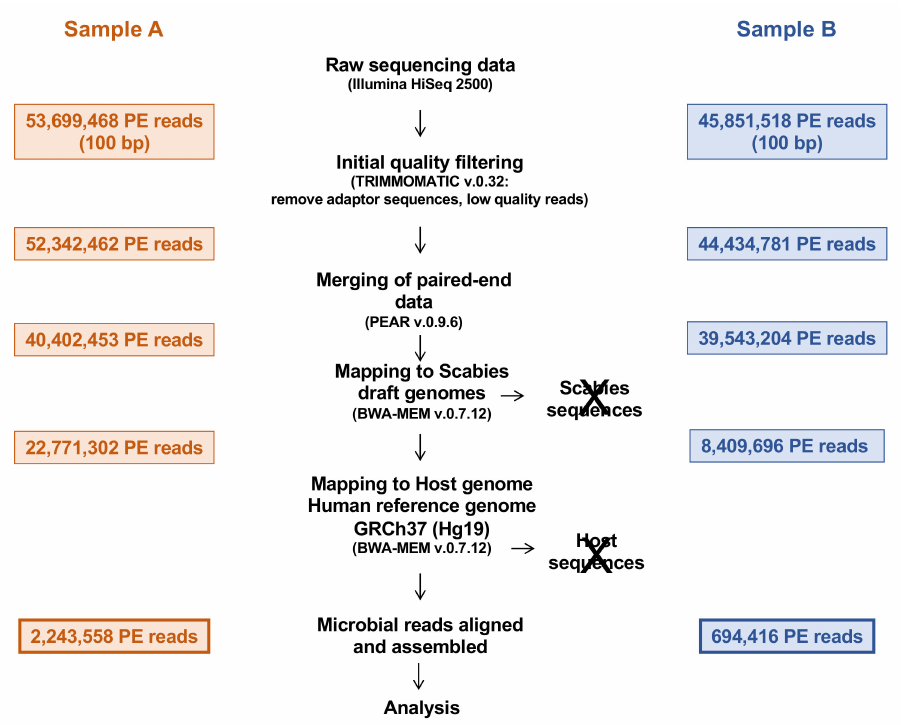
Figure 1. The bioinformatic pipeline illustrating the different steps and the obtained read counts.